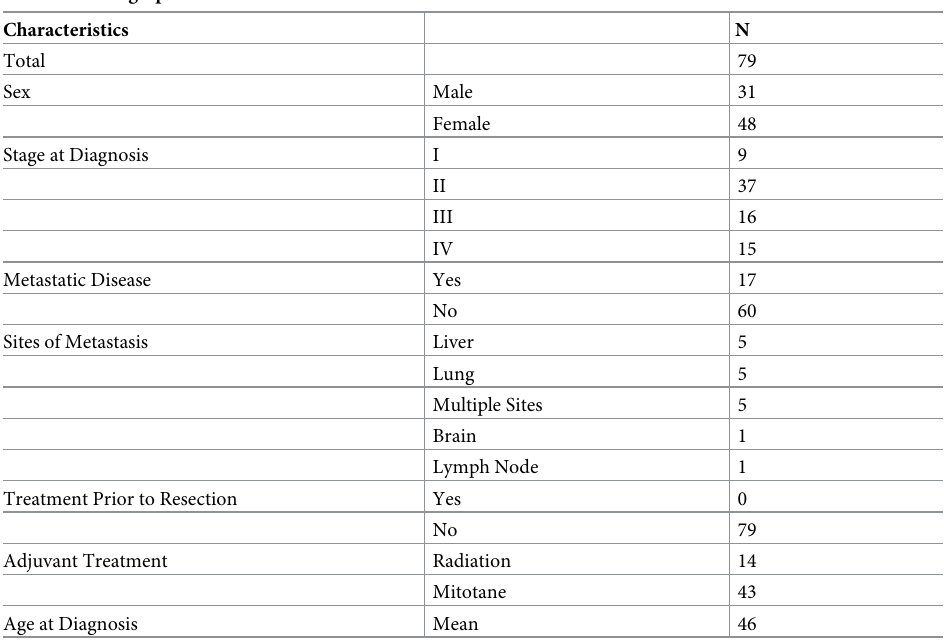
Table 1. Demographic data.